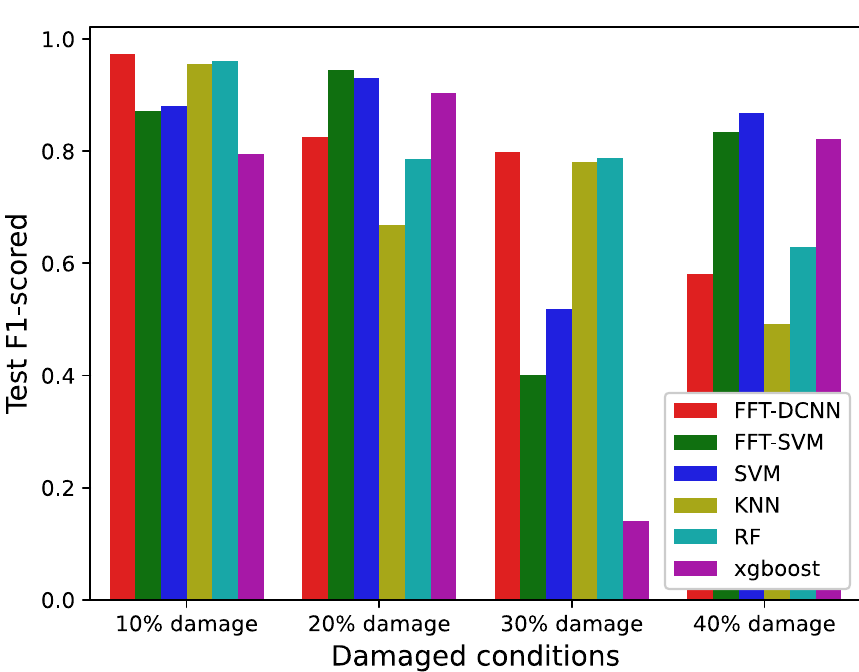
Figure 11. F 1 -scored of the test data using different algorithms.